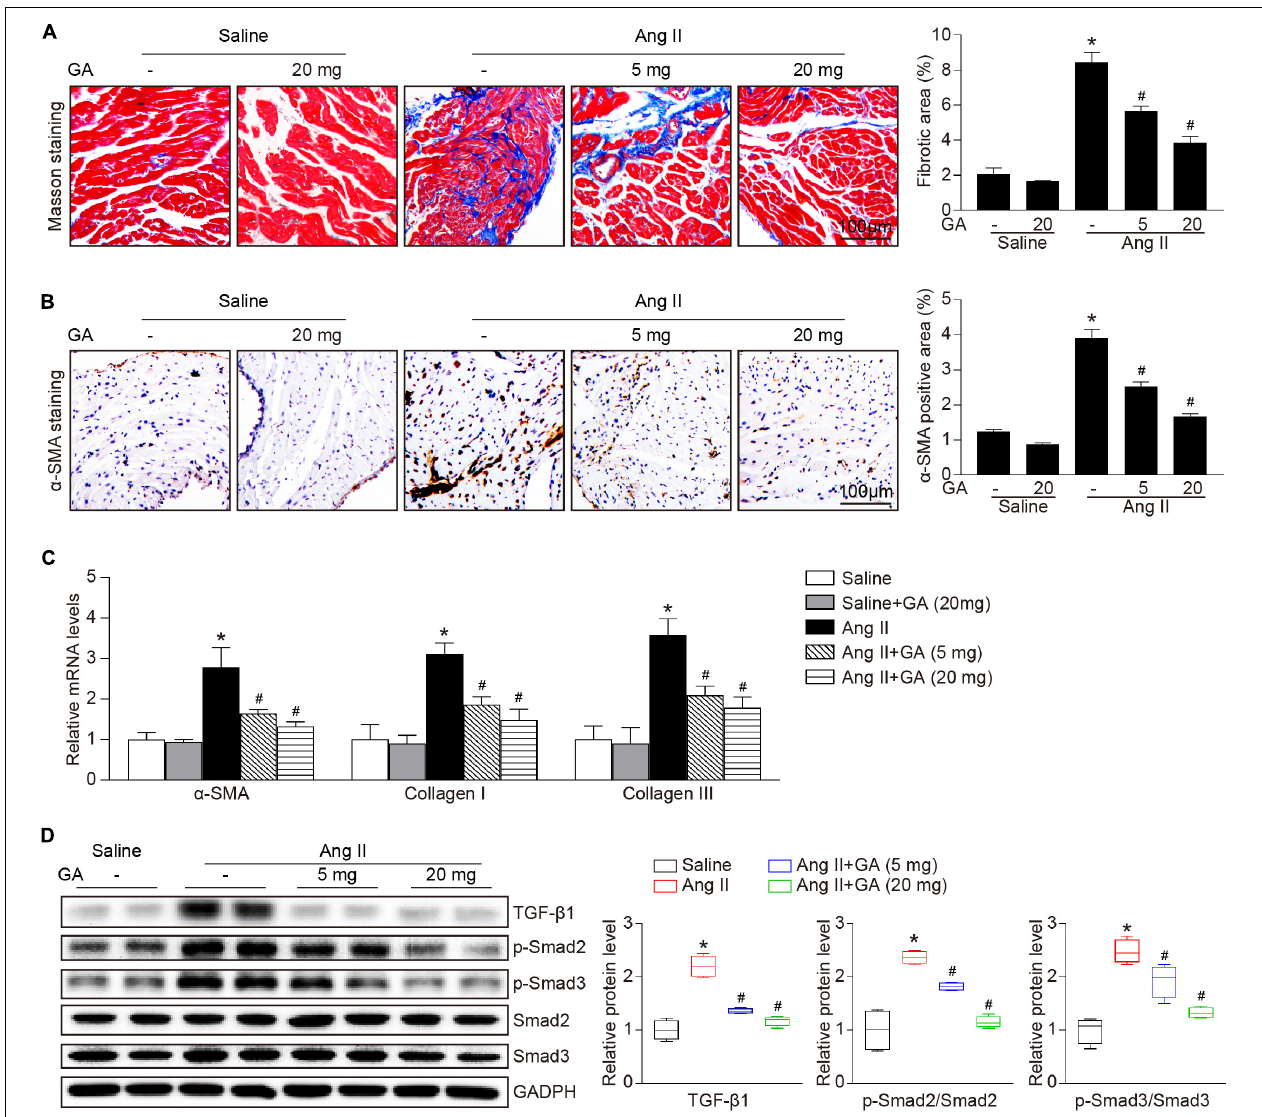
FIGURE 2 | GA inhibits Ang II-induced atrial remodeling. (A) Representative images of Masson trichrome staining for atrial fibrosis (left). Quantification of fibrotic area (right, n = 6). Scale bar: 100 µ m. (B) Representative images of immunohistochemical staining of LA sections to detect myofibroblast activation (left). Quantification of α -SMA + areas (right, n = 6). Scale bar: 100 µ m. (C) qPCR analyses of the mRNA expression levels of α -SMA, collagen I, and collagen III ( n = 6). (D) Immunoblotting analysis of the protein levels of TGF- β 1, p-Smad2/3, and Smad2/3 in the atria (left), and quantification of each protein band (right, n = 4). GAPDH as an internal control. * P < 0.05 versus saline, # P < 0.05 versus Ang